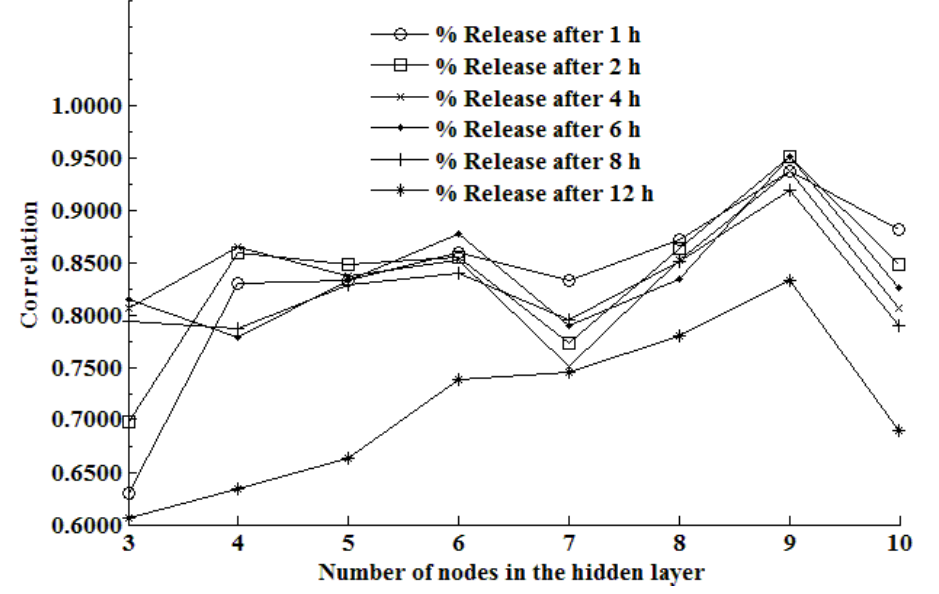
Figure 4. The impact of the number of nodes in the hidden layer of an ANN on the correlation coefficient at different stages of the dissolution